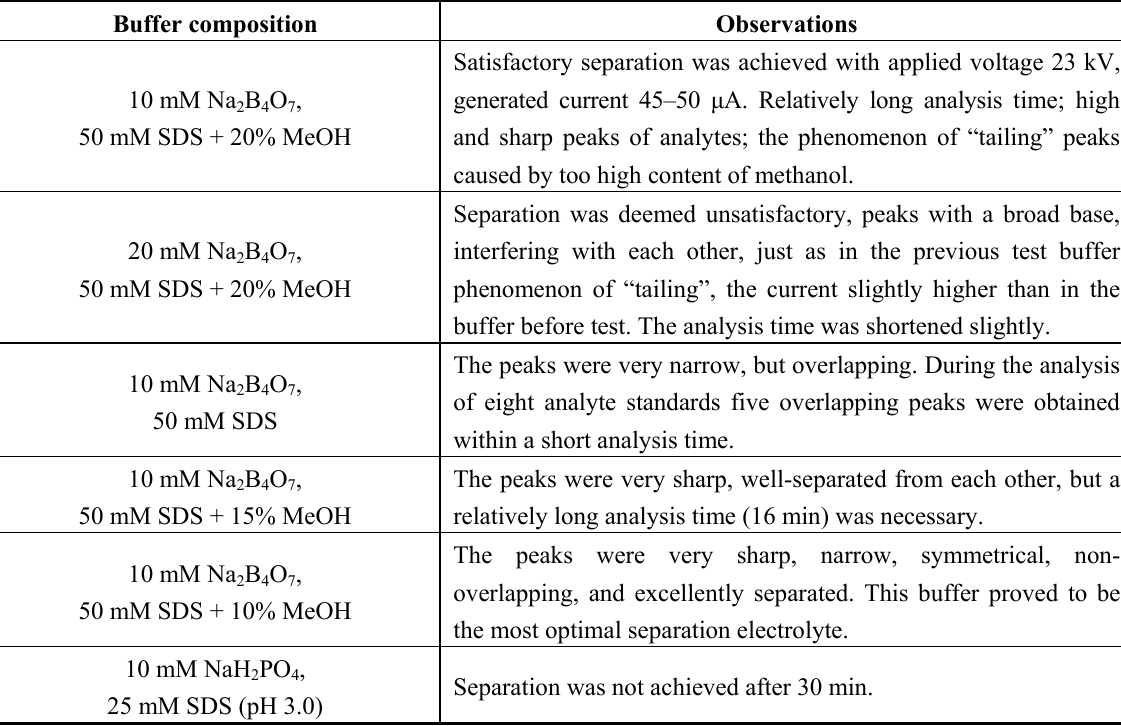
Table 1. The composition of tested buffers and their effect on the electrophoretic view. Buffer composition